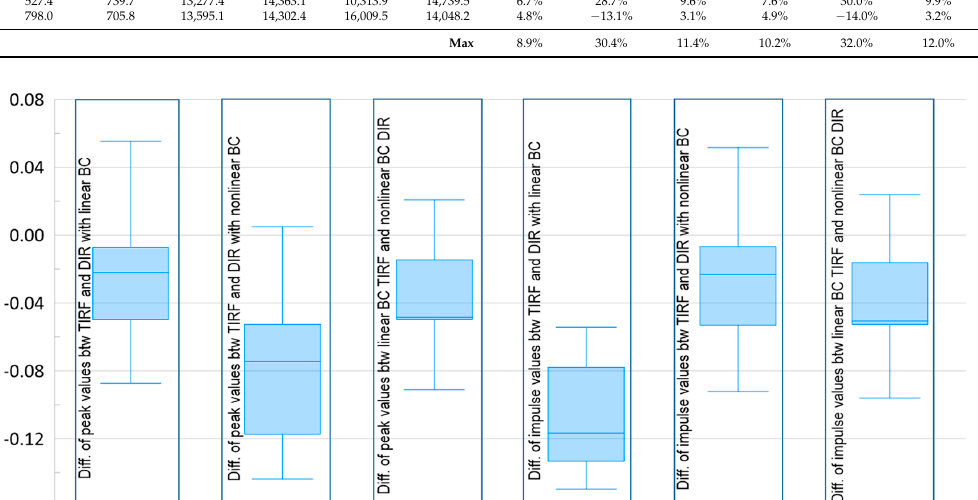
Figure 15. Box and whisker plots for the difference in the peak shear stresses and impulse values using TIRF and DIR.